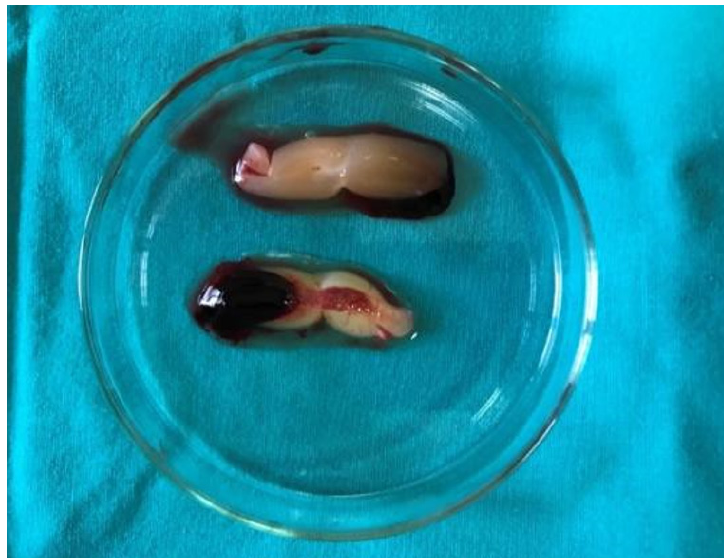
Figure 2. L-PRF taken out of the test tube and placed inside a sterile glass container.